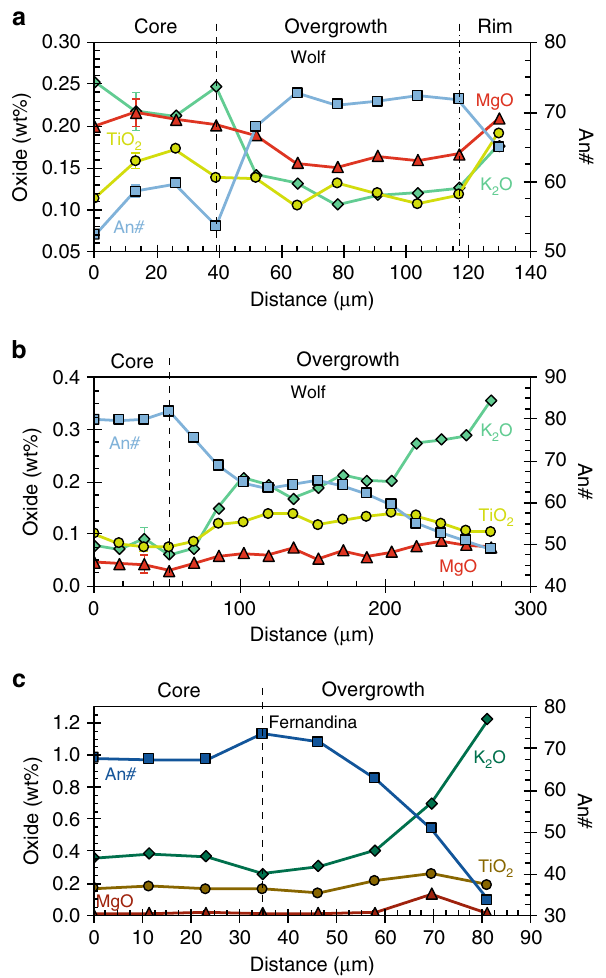
Fig. 6 Selected plagioclase zoning pro fi les. Core-to-rim zoning pro fi les across a a glomerocrystic plagioclase crystal from a 2015 Wolf lava sample, b a plagioclase crystal from a 2015 Wolf tephra sample, and c a plagioclase crystal from a 1968 Fernandina nodule sample. MgO is typically below detection limit in ( c ). Characteristic 2 σ analytical uncertainties are shown or are less than the size of a data